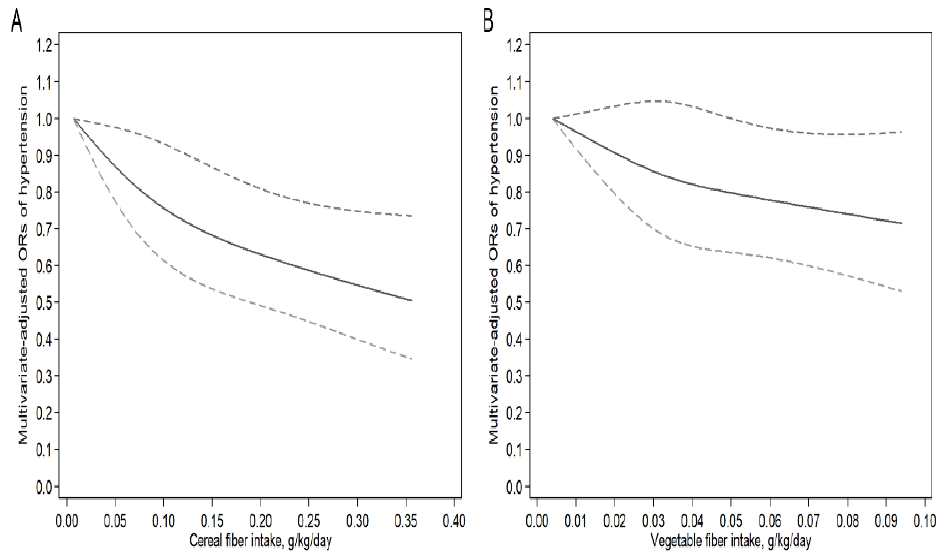
Figure 3. Examination of the dose-response relationship between dietary fiber intake and risk of hypertension by restricted cubic splines model. ( A ) Cereal fiber, P for nonlinearity = 0.34; the lowest level of cereal fiber intake (0.02 g/kg/day) was used as the reference group. ( B ) Vegetable fiber, P for nonlinearity = 0.12; the lowest level of vegetable fiber intake (0.004 g/kg/day) was used as the reference group. The restricted cubic splines model adjusted for age, gender, total energy intake, race, body mass index (BMI), annual household income, smoking status, and educational level. The solid line and dashed line represent the estimated ORs and the corresponding 95% confidence intervals. OR, odds ratio.